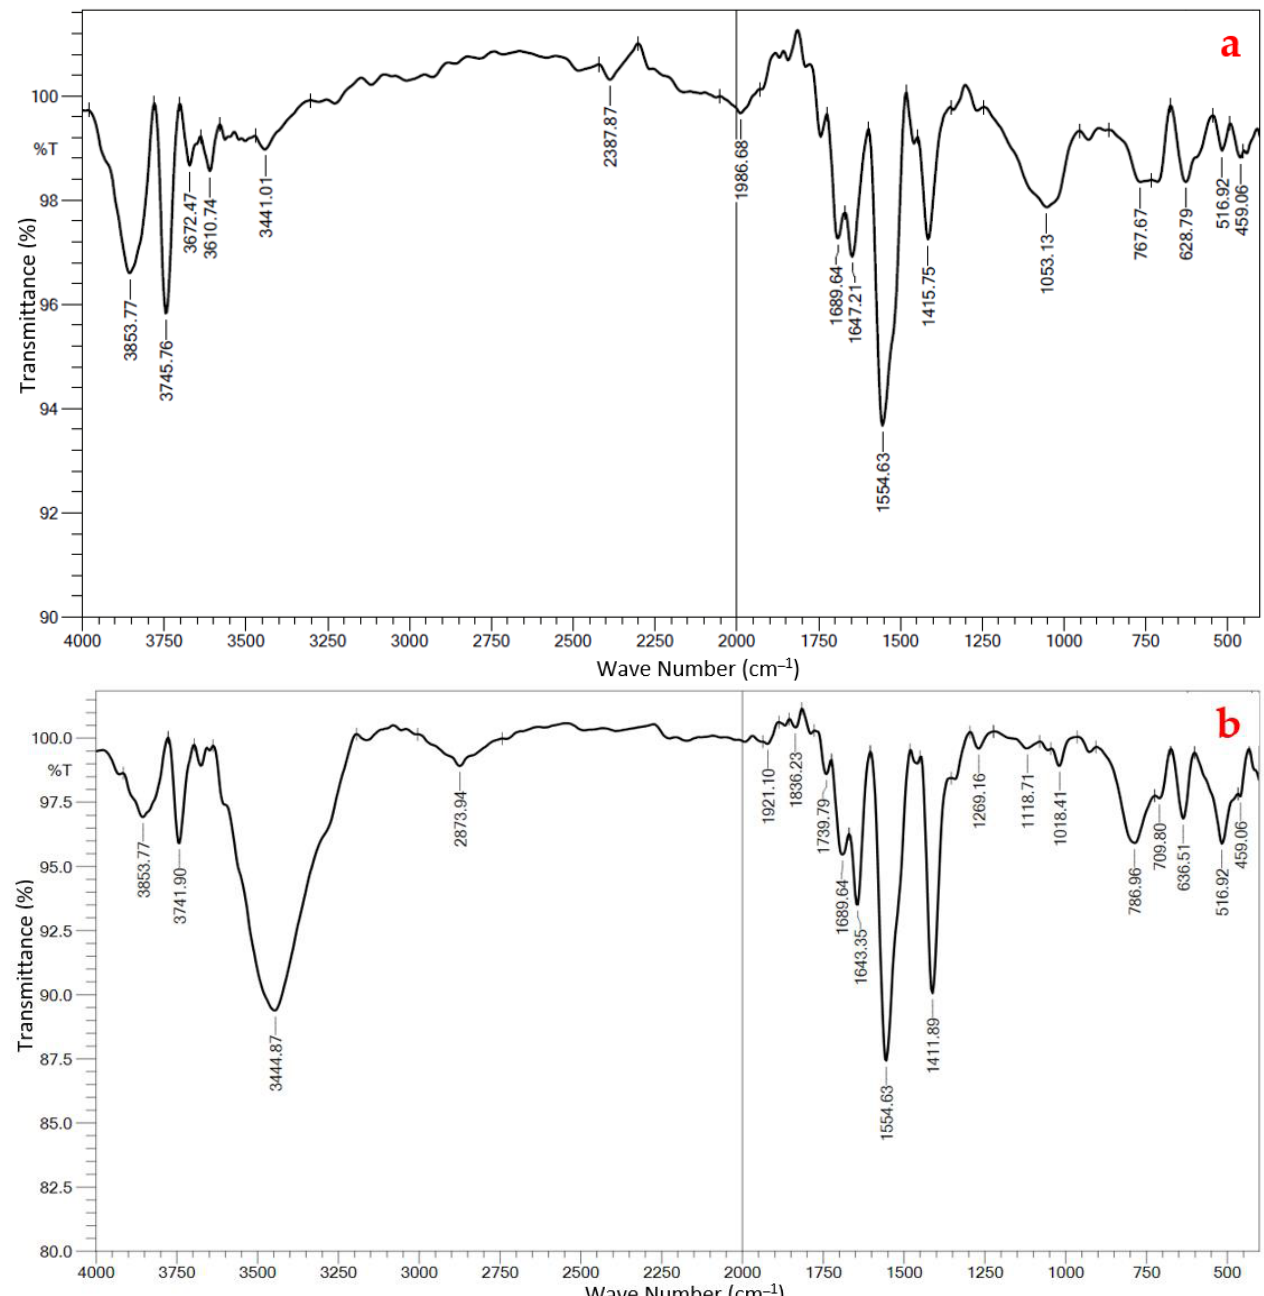
Figure 3. FTIR spectra of nano-TiO 2 : ( a ) net TiO 2 ; ( b ) 5 wt% N-doped TiO 2